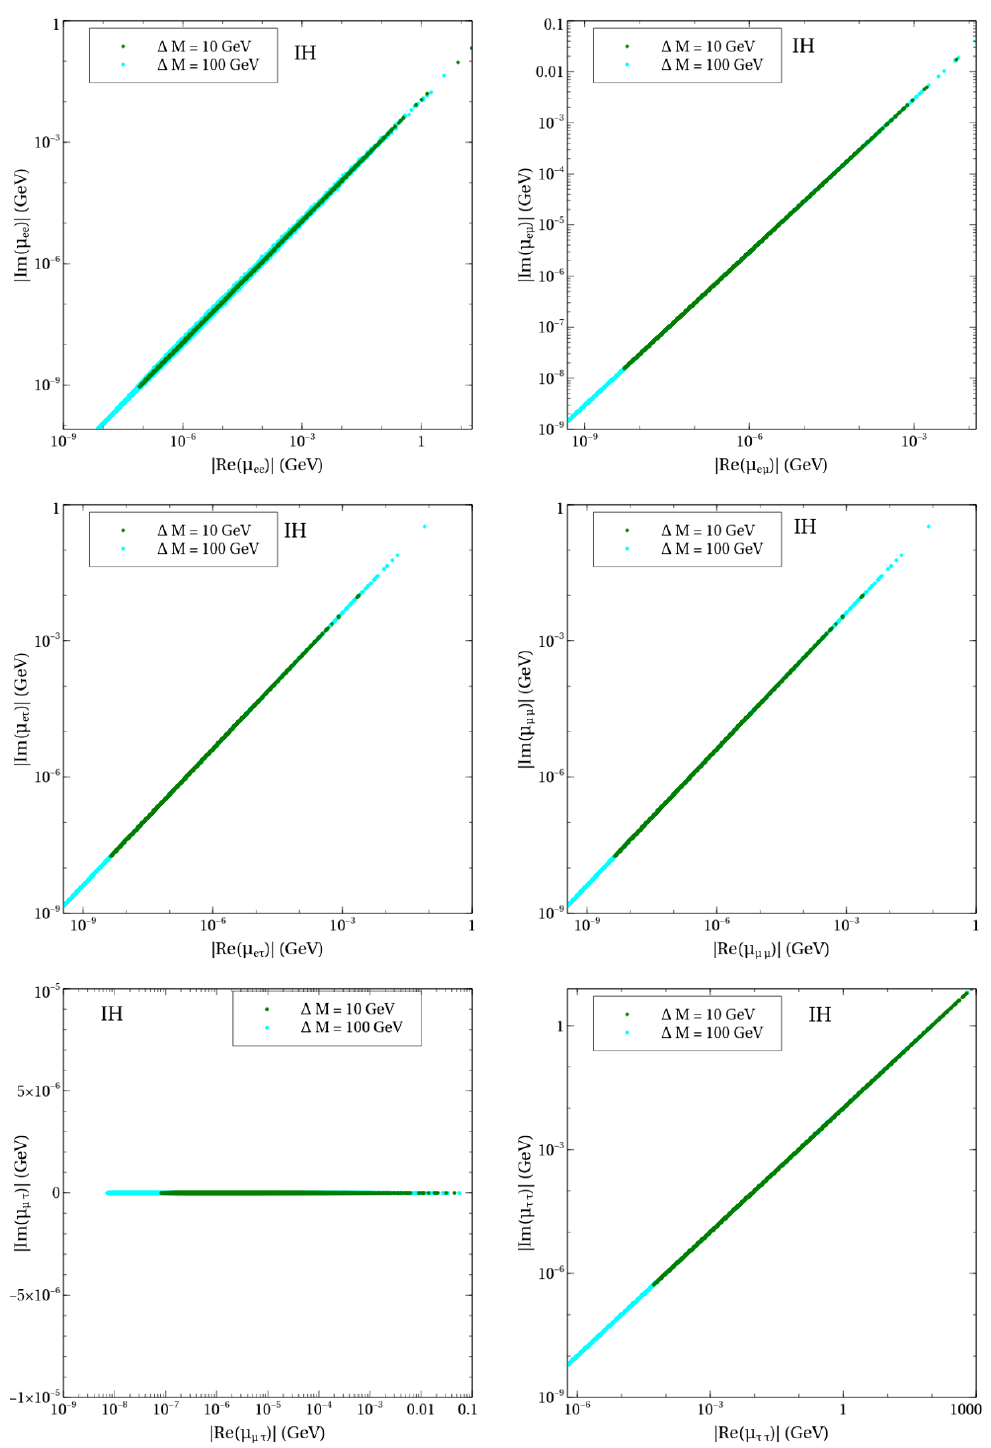
Figure 8 . Allowed values of (cid:22) (cid:11)(cid:12) in the case of inverted hierarchy (IH), plotted in the plane of real vs imaginary axes. The color coding can be read from the legends.